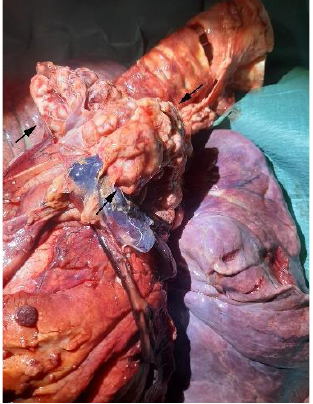
Figure 5. Heart: neoplastic mass at the base of the heart (arrows).